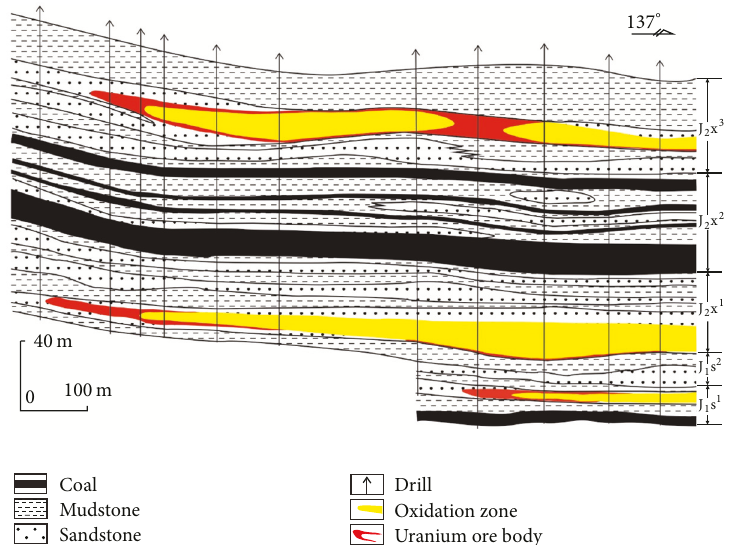
Figure 2: Host strata deposited several coal–sand–coal stacks represent braided river delta sediments. Orebodies occur at downsizing sites of host sandbodies and near contact zones with underlying or overlying mudstone. Lenticular orebodies are located in sandbodies of J 2 x 3 ; roll-shaped and tabular orebodies are comparably located in sandbodies of J 1 s 1 and J 2 x 1 .